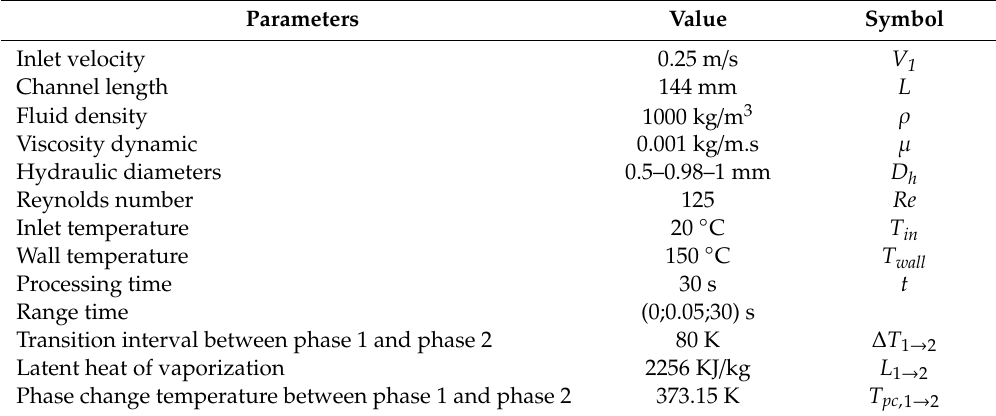
Table 2. Parameters used in COMSOL.